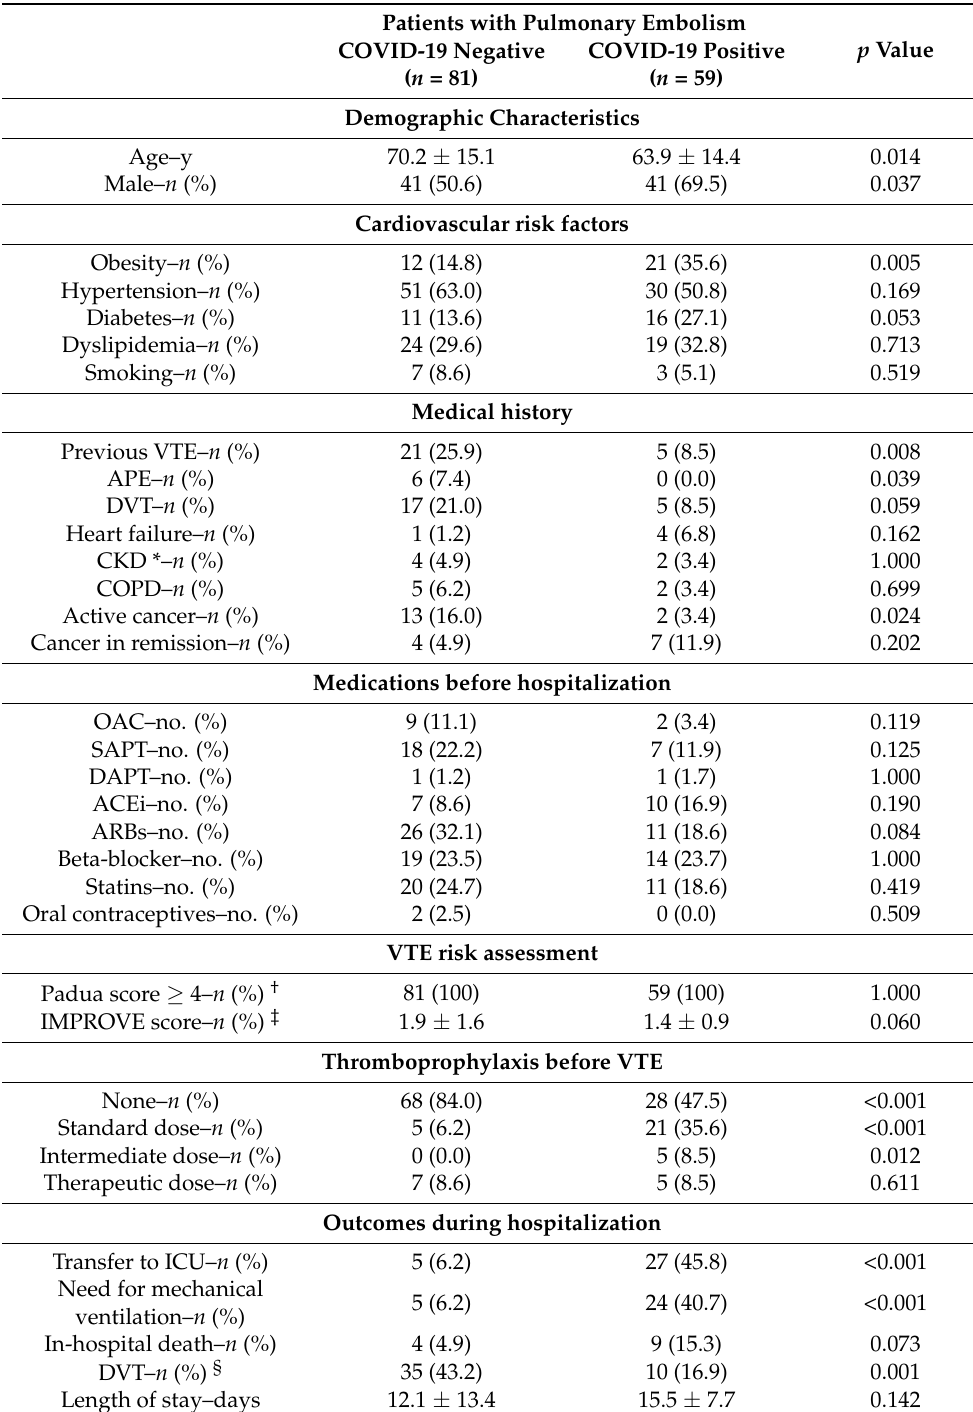
Table 1. Baseline